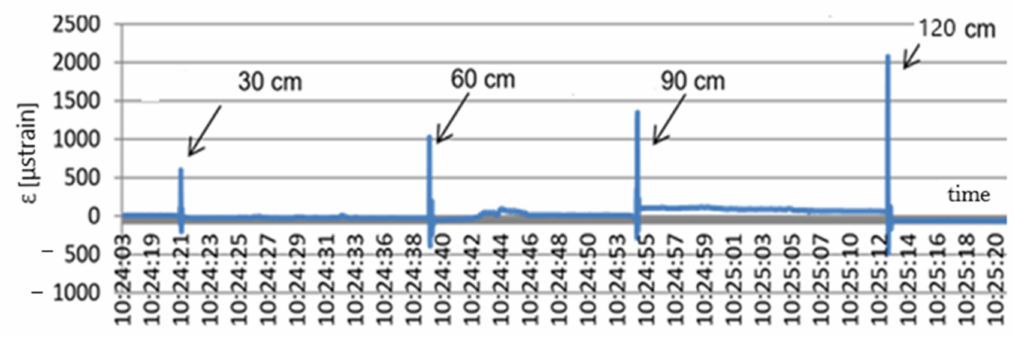
Figure 12. Dynamic test results: x (s); y ( µ